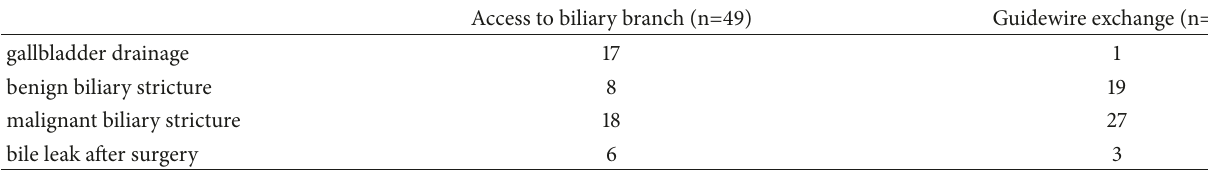
Table 3: Indications for the Swing Tip.